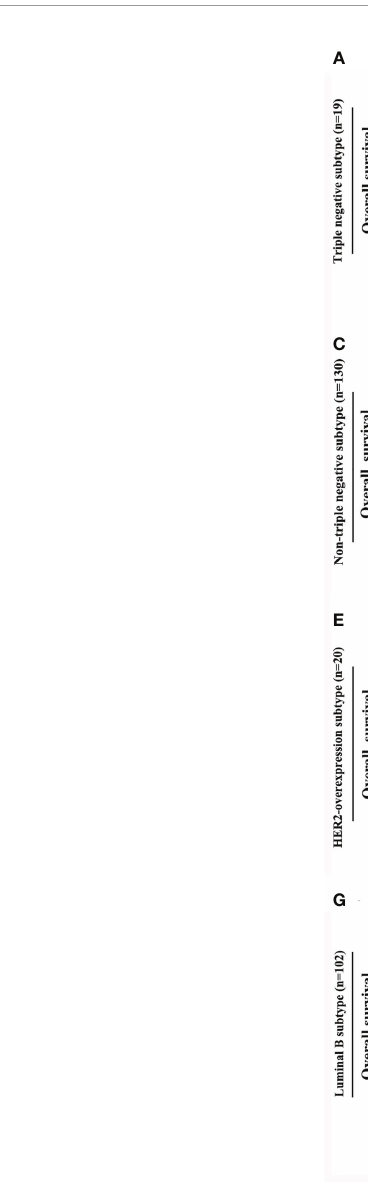
FIGURE 6 | High C7 expression indicated a shorter survival in breast cancer patients treated with TE-based chemotherapy, especially in the luminal B subtype. (A, B) OS and PFS curves of triple negative subtype patients who received TE-based chemotherapy (n = 19). (C, D) OS and PFS curves of non-triple negative subtype patients who received TE-based chemotherapy (n = 130). (E, F) OS and PFS curves of the HER2-overexpression subtype patients who received TE-based chemotherapy (n = 20). (G, H) OS and PFS curves of luminal B subtype patients who received TE-based chemotherapy (n = 102). [ (A – H) : log-rank